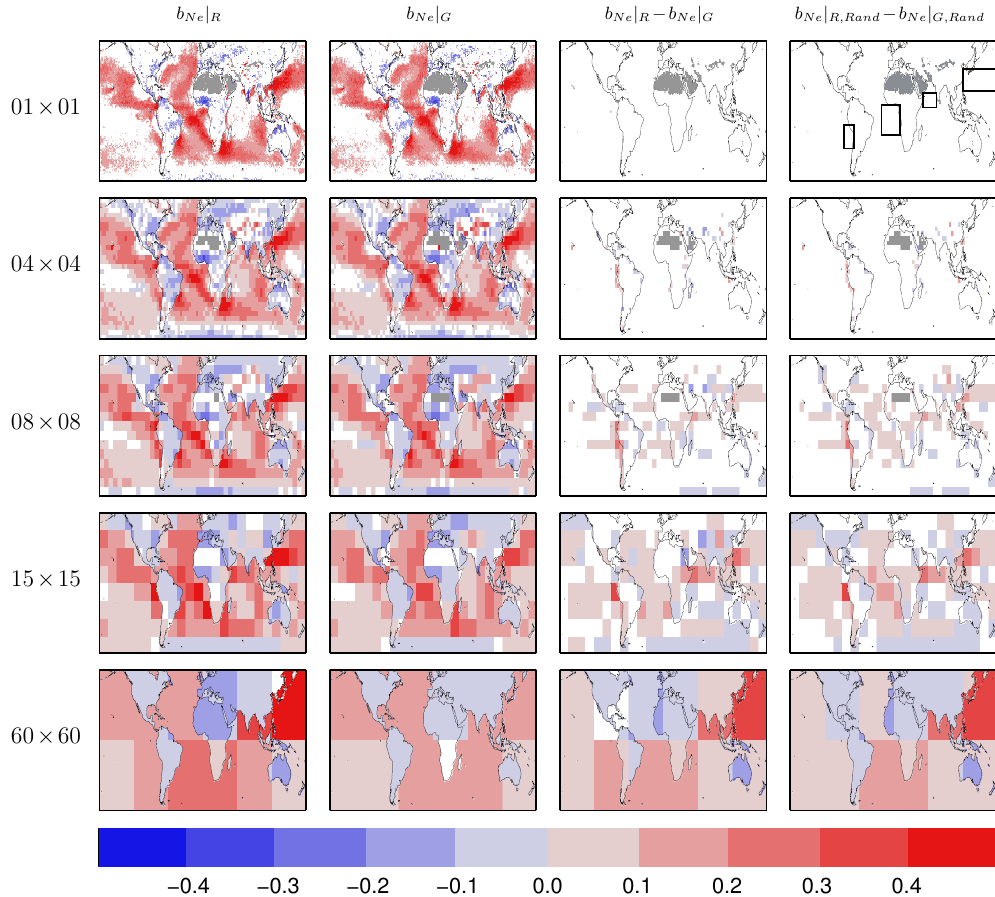
Fig. 3. Annual mean sensitivity of N e to τ a for different region sizes. The first column shows the results when the region–method; the second column is for the grid–method; the third column is the difference between the region–method and grid–method sensitivities; the fourth column is the difference when the data has first been randomised within each season and 1 ◦ × 1 ◦ grid box. White regions are where the data is not significantly different from zero at two–sigma confidence. Grey represents missing data.